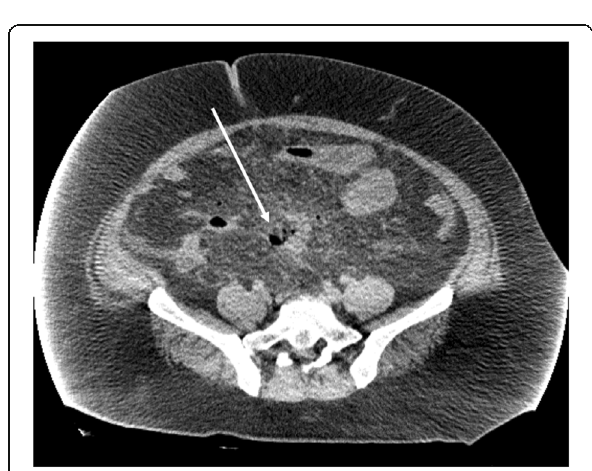
Fig. 2 Abdominal computed tomography showing free air